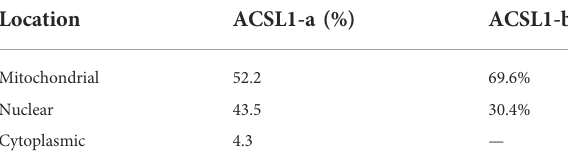
TABLE 2 Prediction of sheep ACSL1 subcellular